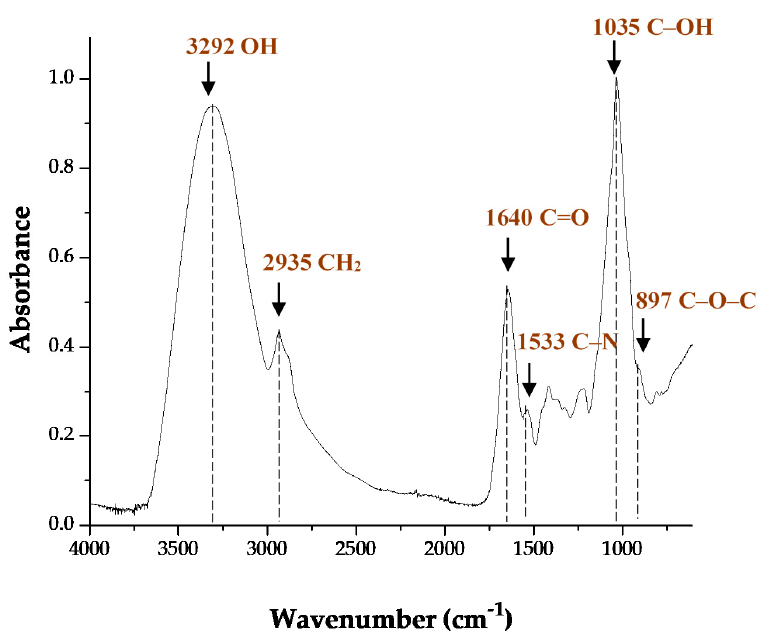
Figure 4. FTIR spectrum of AX from distillers' grains with solubles (DDGS).